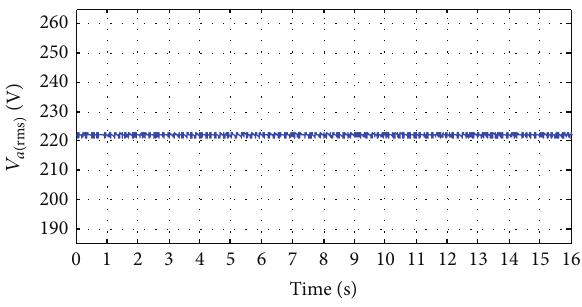
Figure 25: The output RMS phase